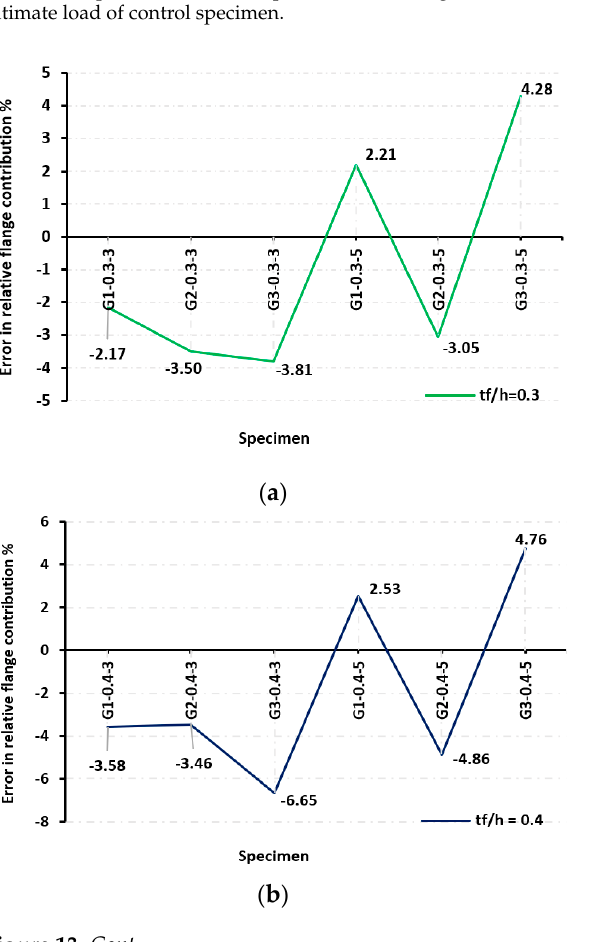
( c ) Figure 13. Error in relative flange contribution between all tested specimens with and without web stirrups by FE model. They should be listed as: ( a ) specimens with t f /h = 0.3; ( b ) specimens with t f /h = 0.4; ( c ) specimens with t f /h = 0.5. 7. Conclusions Based on the presented test and finite element results, and within the limits of the adopted specimens’ sizes, arrangement, and reinforcement, the following conclusions were drawn (note that tested beams had no shear reinforcement in the web): 1. The shear capacity of T-beams was notably higher than that of rectangular beams with the same web size. The actual increase depended on the flange dimensions and the amount of reinforcement in the flange. Moreover, the cracking load of T-beams was slightly higher than that of beams without the flange.